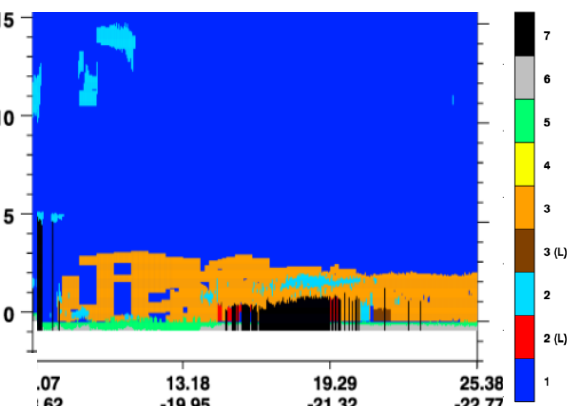
Figure A1. CALIPSO Level 2 Vertical Mask Feature for the 9 May 2007 case study. Color key: 1: clear air, 2: cloud, 3: aerosol, 4: strato- spheric layer, 5: surface, 6: subsurface, 7: totally attenuated beam.